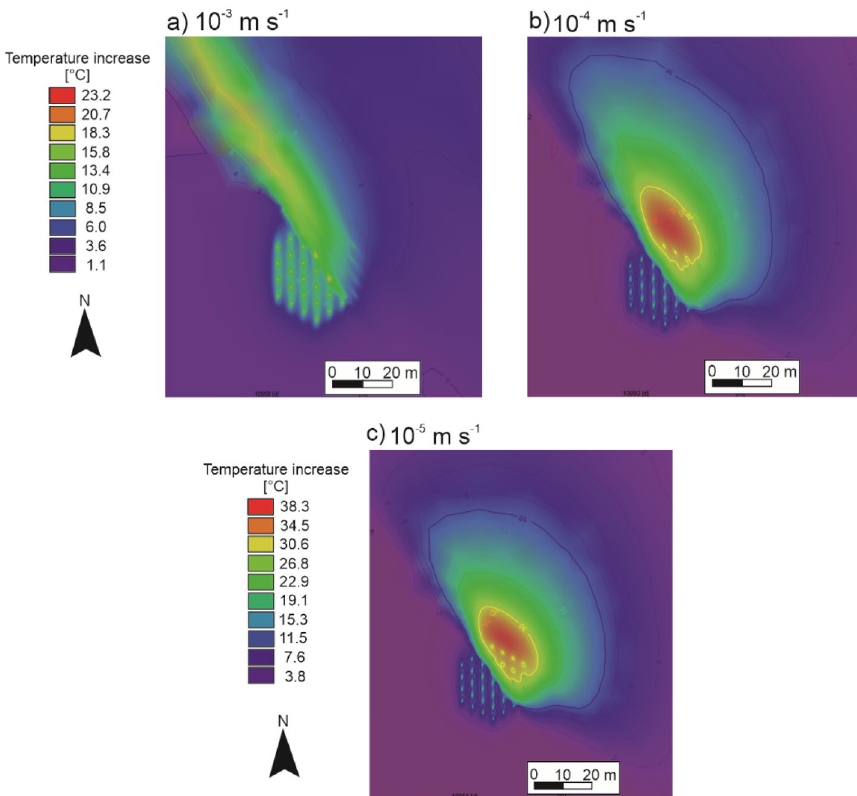
Fig. 13 Resulting heat plumes after a simulation time of 30 years after the last extraction period for a fault with a thickness of 0.5 m and conductivities of a 10 3 m s 1 , b 10 4 m s 1 and c 10 5 m s